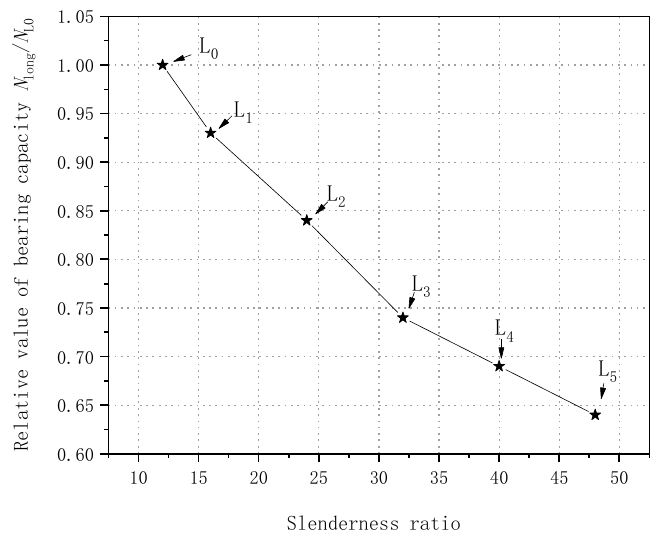
Figure 3. Peak load–slenderness ratio relationship for CFGT composite columns.